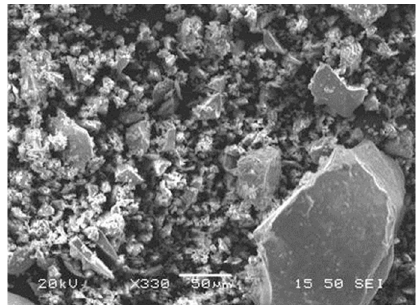
Figure 3. Microstructure images of copper slag at 330 × magnification and 50 µ m scale.